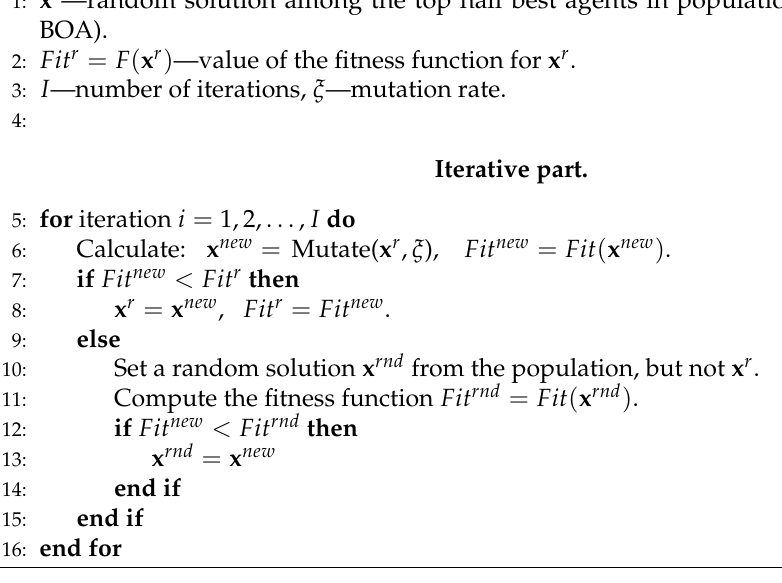
Algorithm 3 Pseudocode of